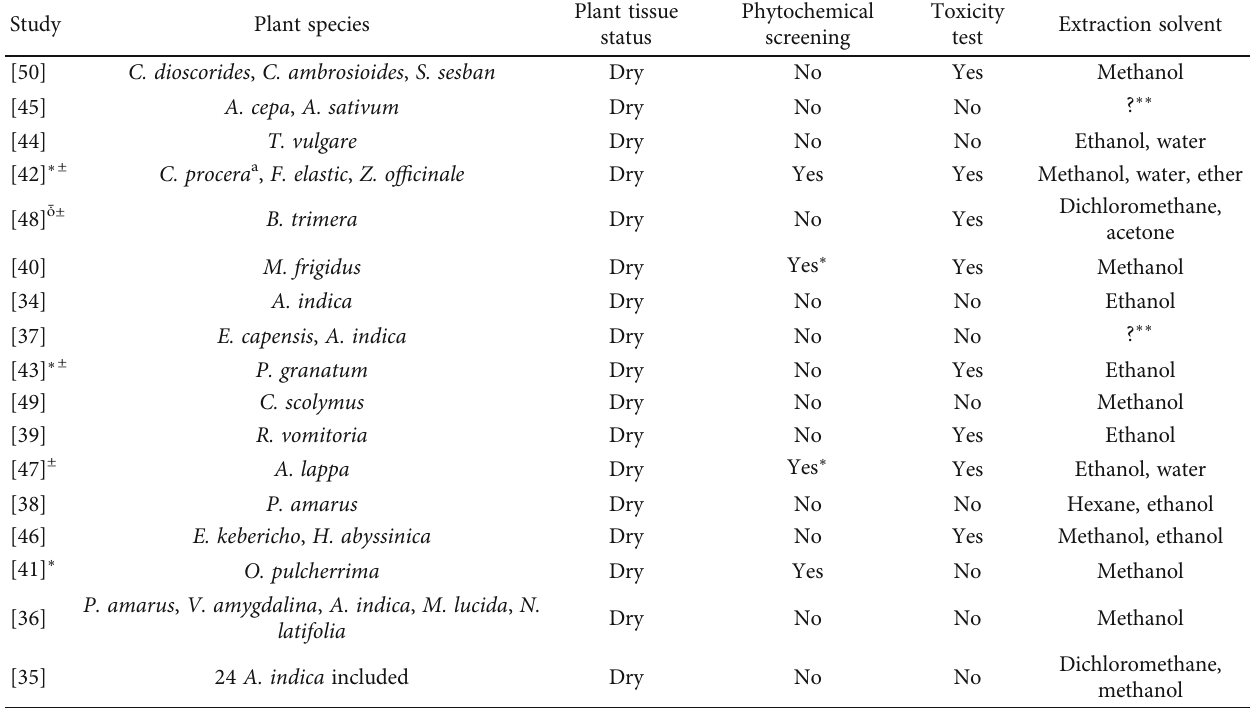
Table 2: Plant species, status of tissue used, extraction solvent, toxicity, and phytochemical tests.